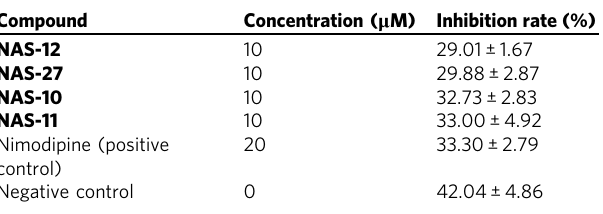
Table 1 The protective effects of some most potent NAS analogs against glutamate-induced PC-12 cell apoptosis